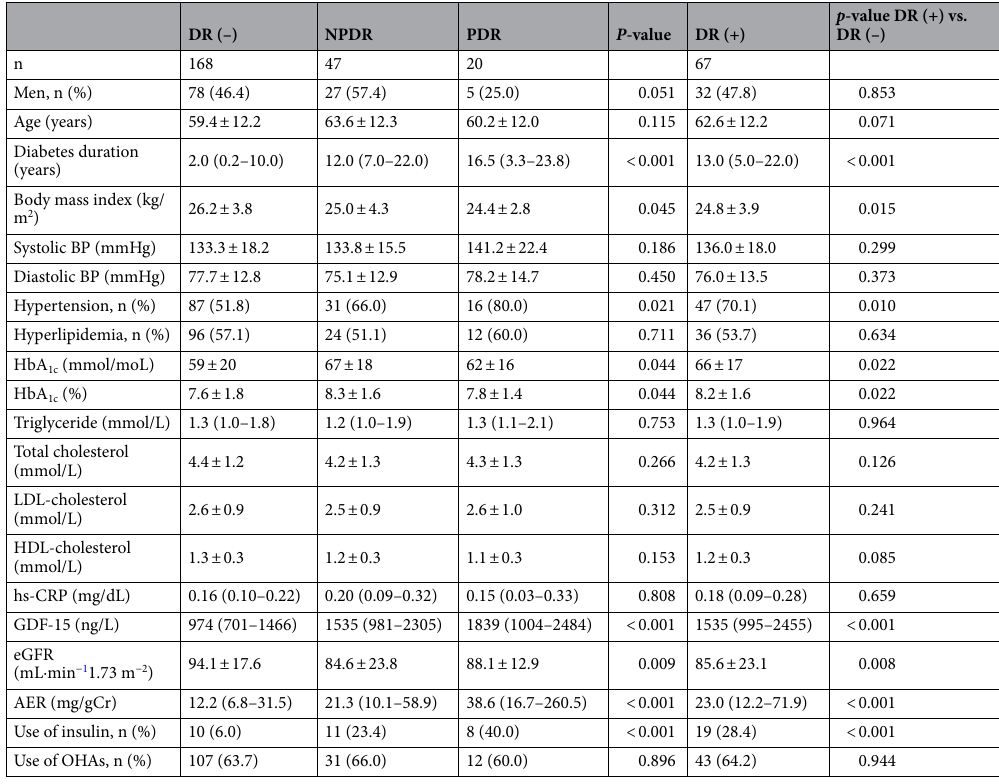
Table 1. Characteristics of patients with type 2 DM according to diabetic retinopathy. The values are expressed as mean ± standard deviation or median (interquartile range) unless otherwise noted. AER, albumin excretion rate; BP, blood pressure; DM, diabetes mellitus; DR, diabetic retinopathy; eGFR, estimated glomerular filtration rate; GDF-15, growth differentiation factor-15; HbA 1c , glycated hemoglobin; HDL– cholesterol, high density lipoprotein cholesterol; hs-CRP, high-sensitivity C-reactive protein; LDL–cholesterol, low density lipoprotein cholesterol; NPDR, nonproliferative diabetic retinopathy; OHAs, oral hypoglycemic agents; PDR, proliferative diabetic retinopathy.